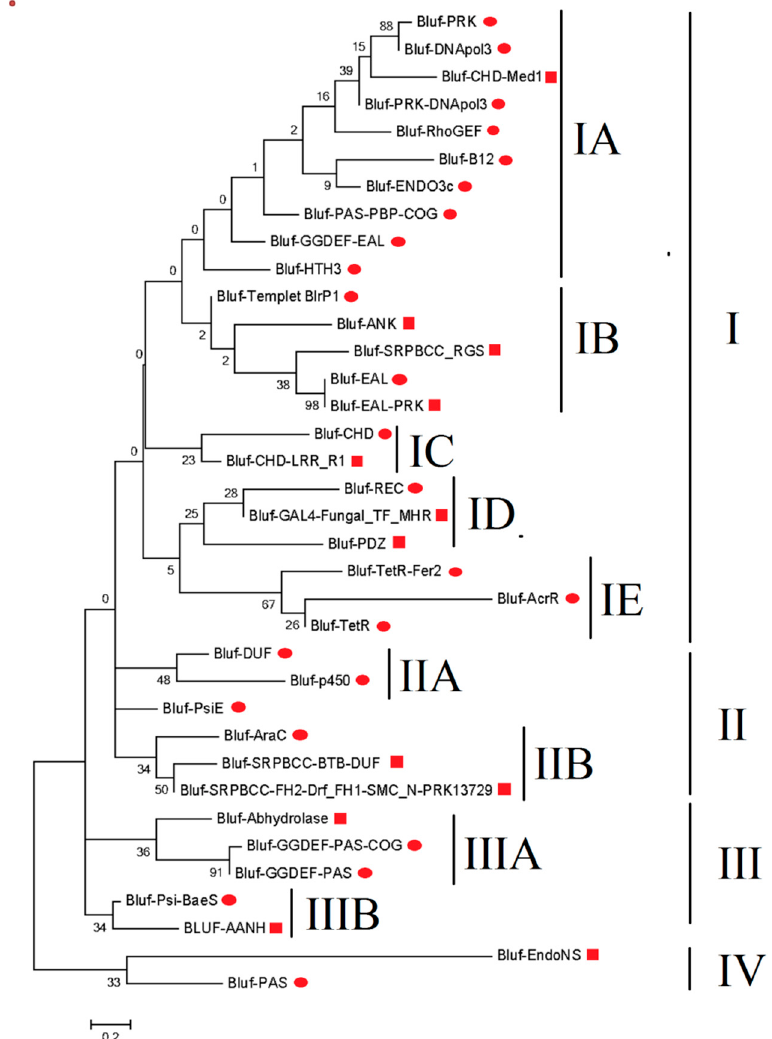
Figure 3. Phylogenetic analysis by the Maximum Likelihood (ML) method. The analysis was done using 34 amino acid sequences of the modular BLUF domain containing proteins. All positions containing gaps and missing data were eliminated. There were a total of 17 positions in the final dataset. A solid red circle represents protein sequences of prokaryotic origin, and a solid red square represents protein sequences of eukaryotic origin. Evolutionary analyses were conducted using MEGA6 [51].